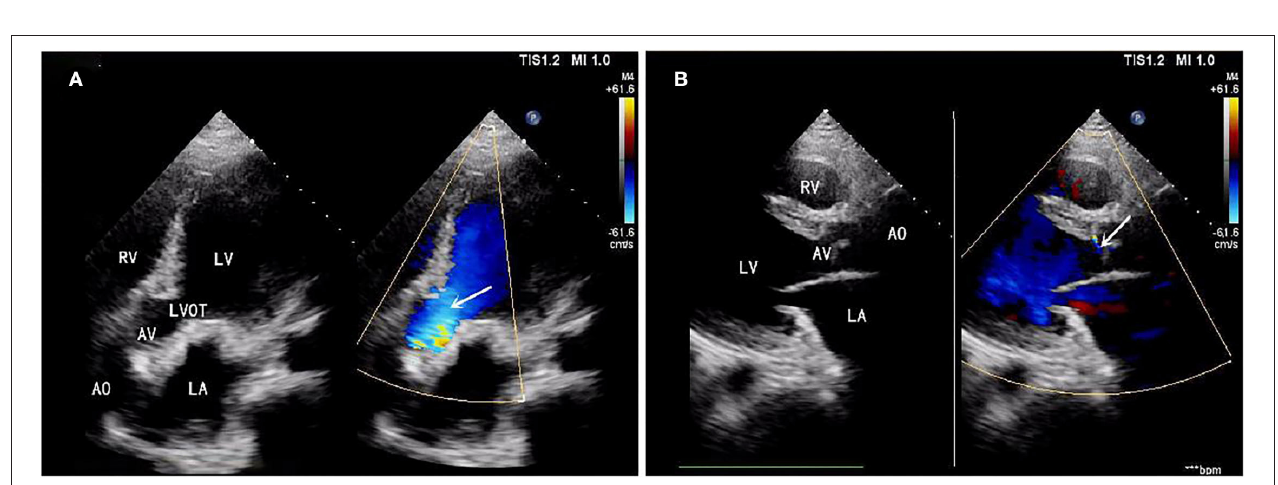
FIGURE 4 | (A) atrophy and degeneration of smooth muscle in media of aortic wall (A × 50, hematoxylin, and eosin stain). (B) focal vitreous degeneration, myxoid degeneration (B × 200, hematoxylin, and eosin stain).